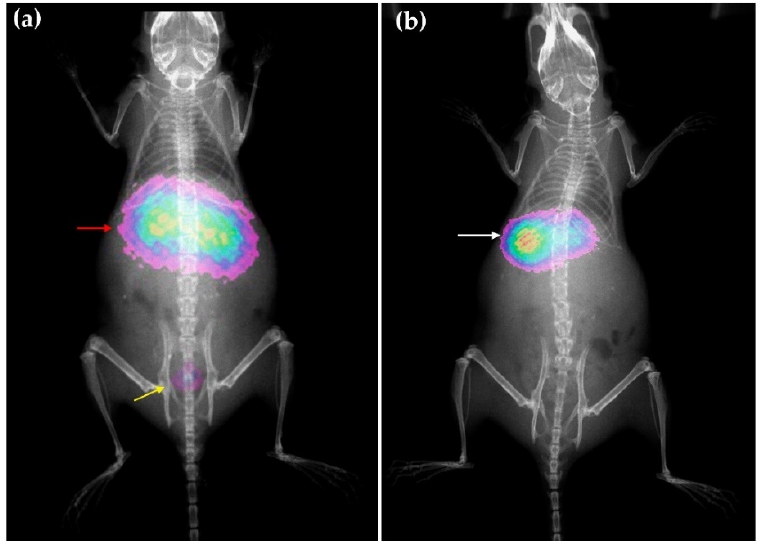
Figure 8. Molecular imaging obtained in mice at 2 h after intravenous administration of rHDL nanosystems, ( a ) optical image (Cerenkov/X-ray image) for 177 LuDOTA-rHDL and ( b ) radioisotopic/X-ray image for 99m Tc-HYNIC-rHDL. Observe the overlapping of liver and kidney (red arrow) as a consequence of the 177 Lu-DOTA-rHDL uptake in both organs, as well as the radiotracer elimination through the bladder (yellow arrow); 99m Tc-HYNIC-rHDL showed mainly liver uptake (white arrow).